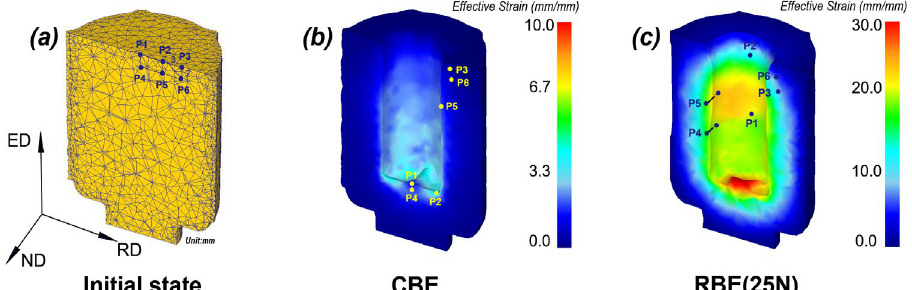
Figure 3. ( a ) The initial billet marked with selected nodes of interest, and effective strain distributions with tracking results for initial nodes under: ( b ) conventional backward extrusion (CBE) and ( c ) RBE (25 N).